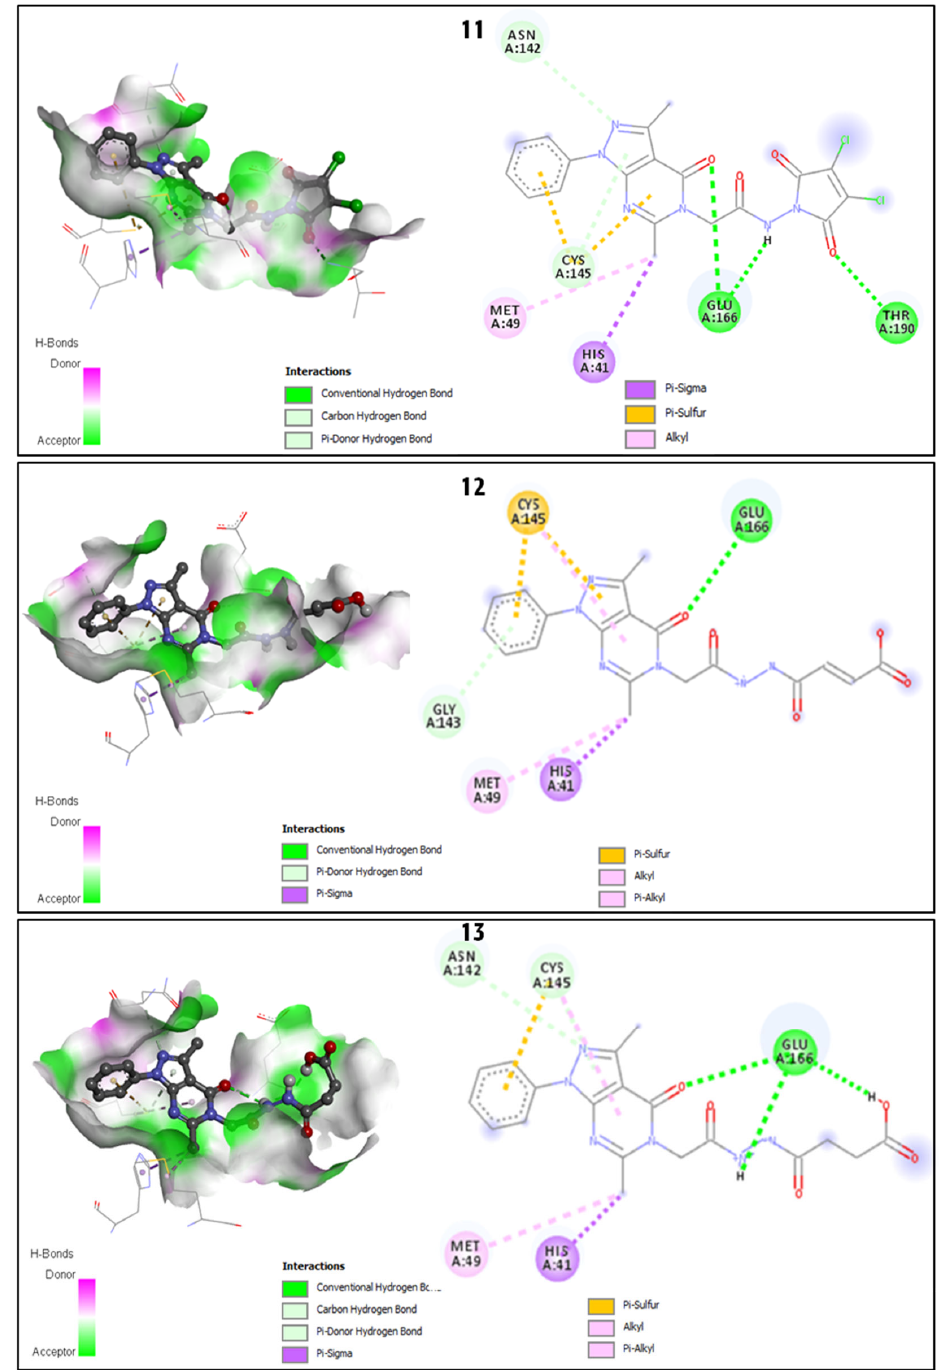
Figure 5. Representation of the 3D structure of the docked compounds 11 , 12, and 13 bound to the pocket region of SARS ‐ CoV ‐ 2 M pro with the hydrogen bond ( left ) and the corresponding 2D diagram of the interactions ( right ).